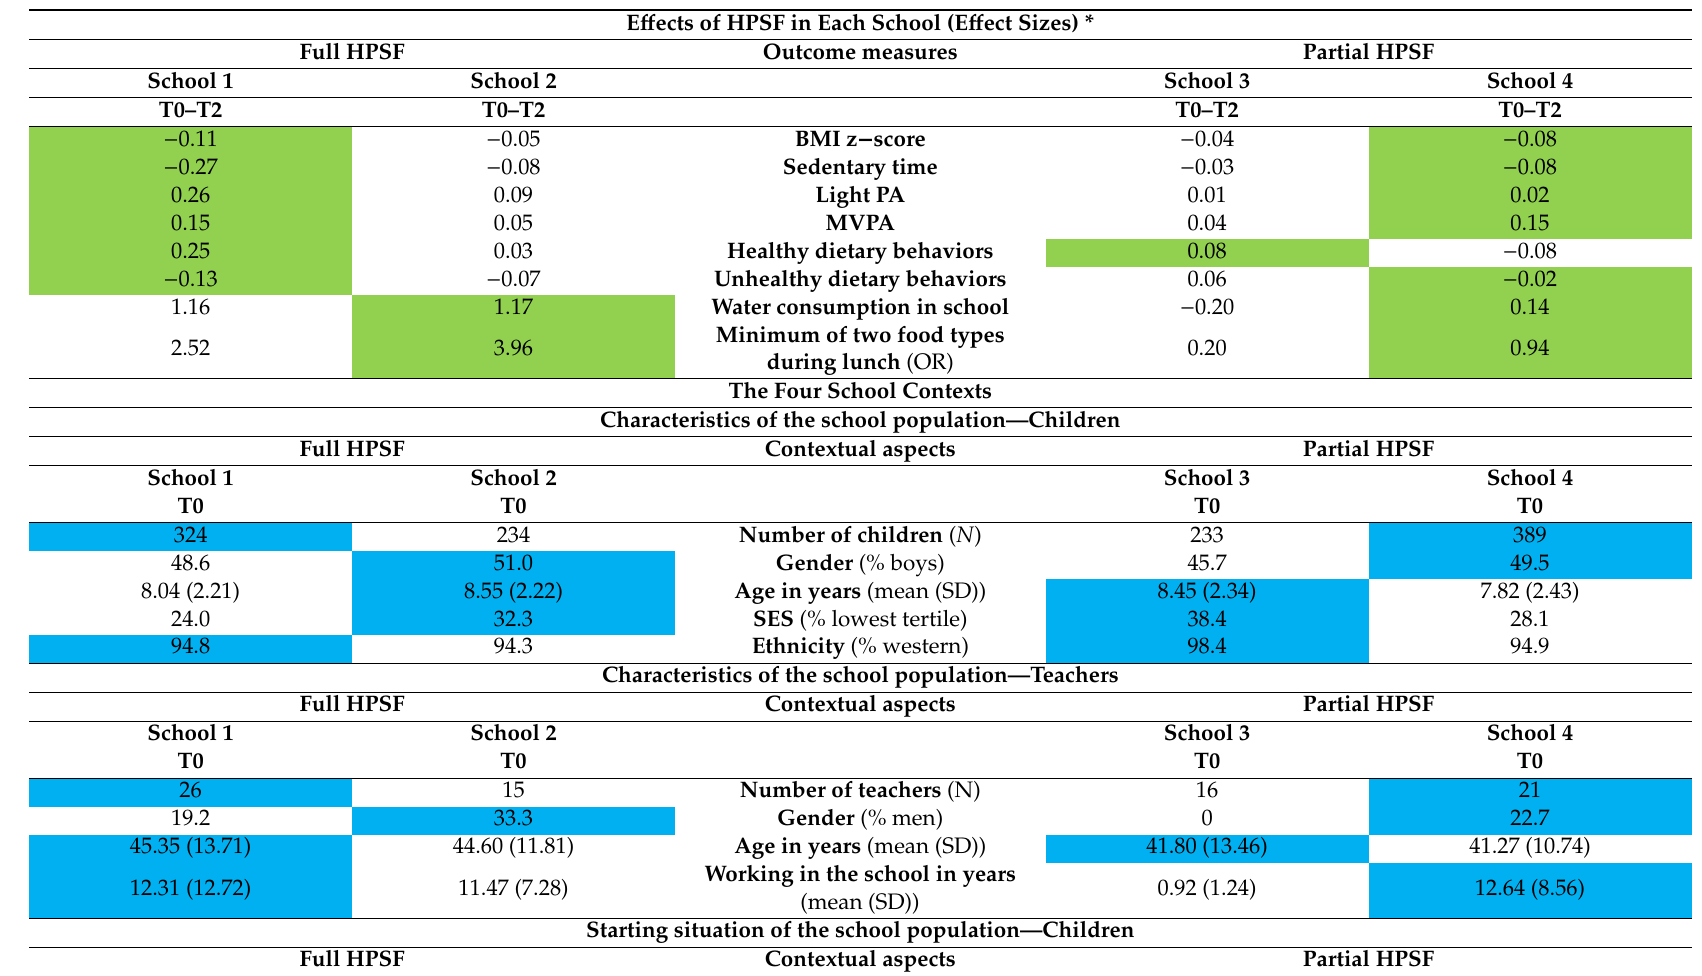
Table 1. The e ff ects of HPSF in each school and the four school contexts. E ff ects of HPSF in Each School (E ff ect Sizes)